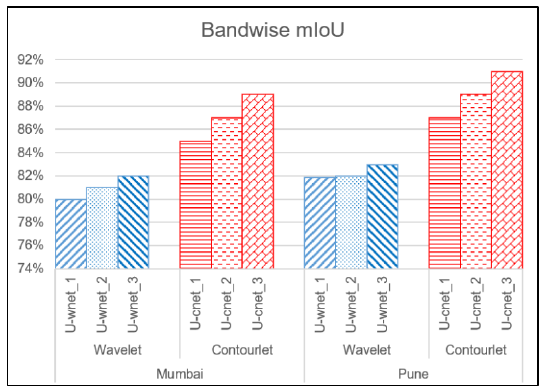
Figure 7. Band-wise overall accuracy.